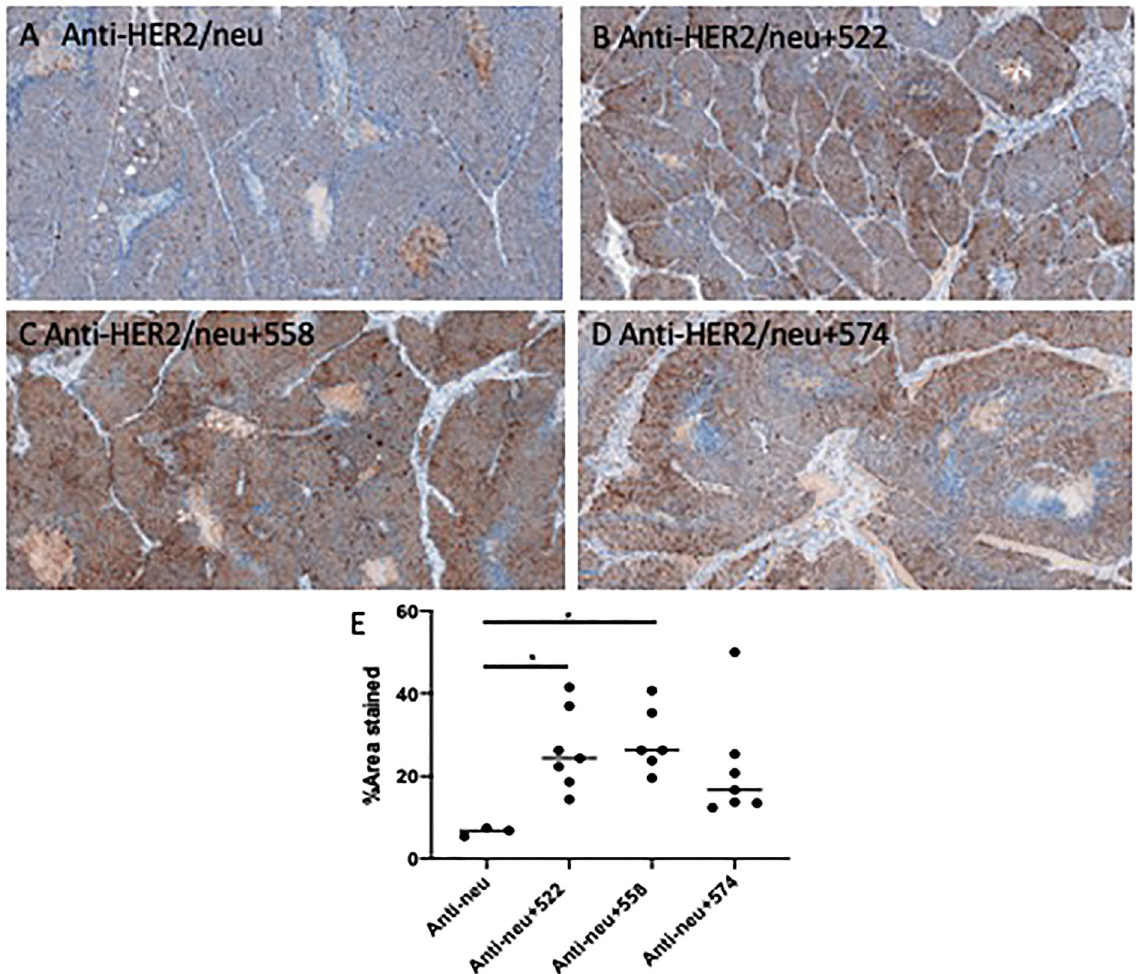
Figure 6. Ex vivo IHC analysis of CD8 T cell infiltration. Representative images presented from each group. Brown is indicative of positive staining. (A) Anti-HER2/neu (B) Anti-HER2/neu (C) Anti-HER2/neu + 558 (D) Anti-HER2/neu + 574 (E) Quantified